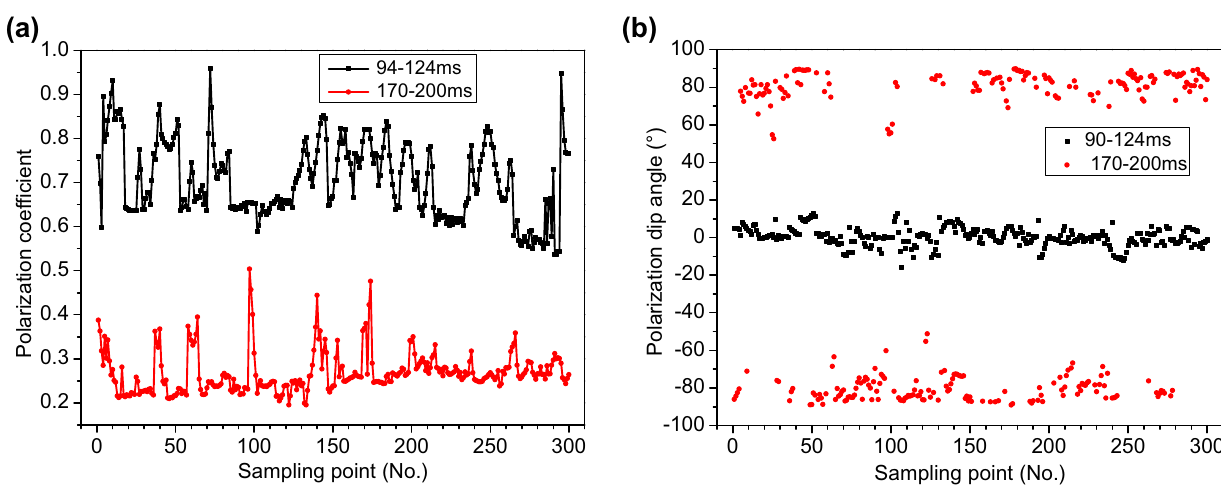
Fig. 8 Polarization parameters of the records in Receiver No. 11 of the 11th single shot: a Polarization coefficient, b Polarization dip angle